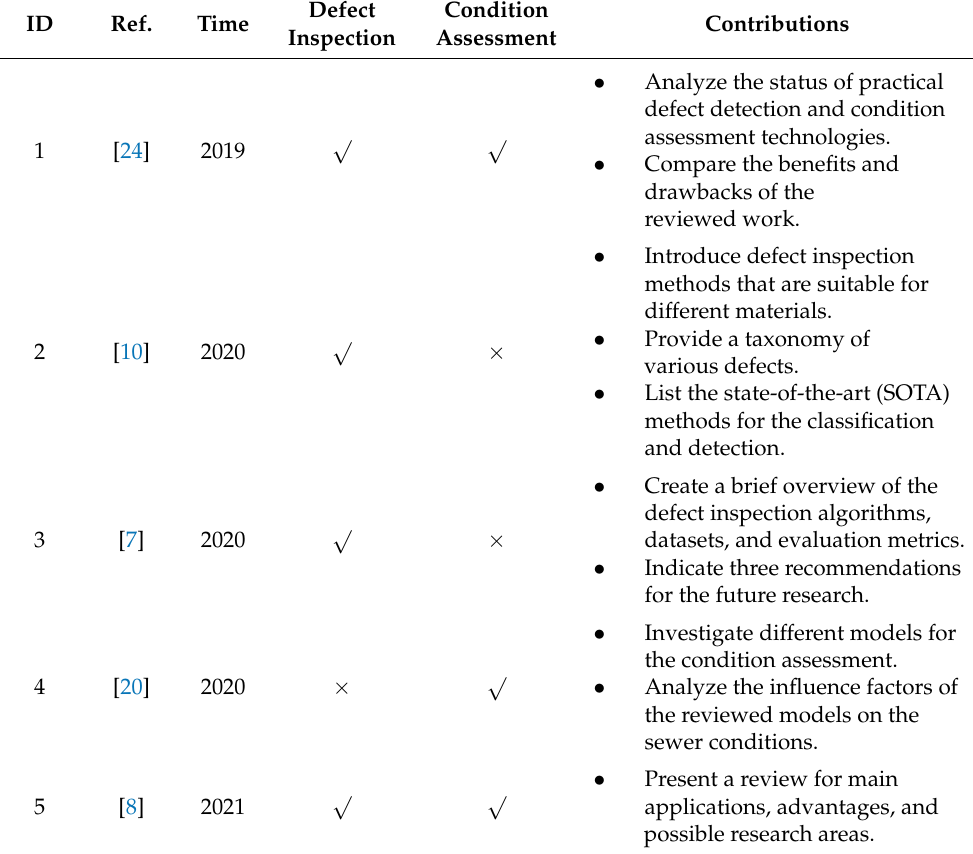
Table 1. Major contributions of the previous review papers on defect inspection and condition √ assessment. ‘ ’ indicates the research areas (defect inspection or condition assessment) are involved. ‘ × ’ means the research areas (defect inspection or condition assessment) are not